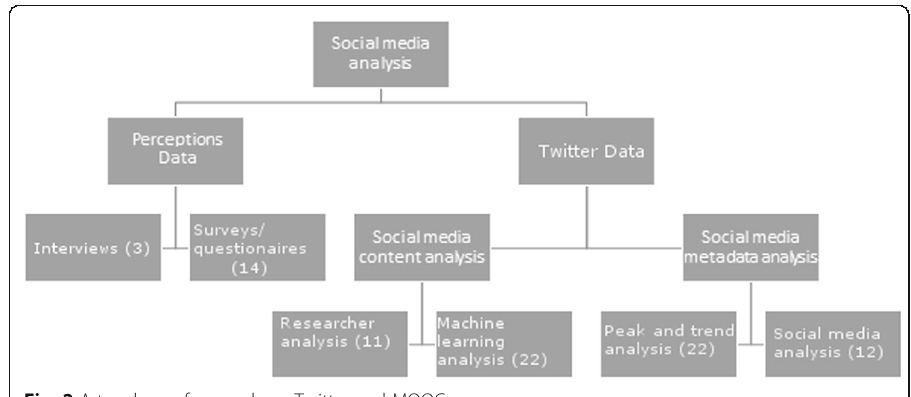
Fig. 2 A typology of research on Twitter and